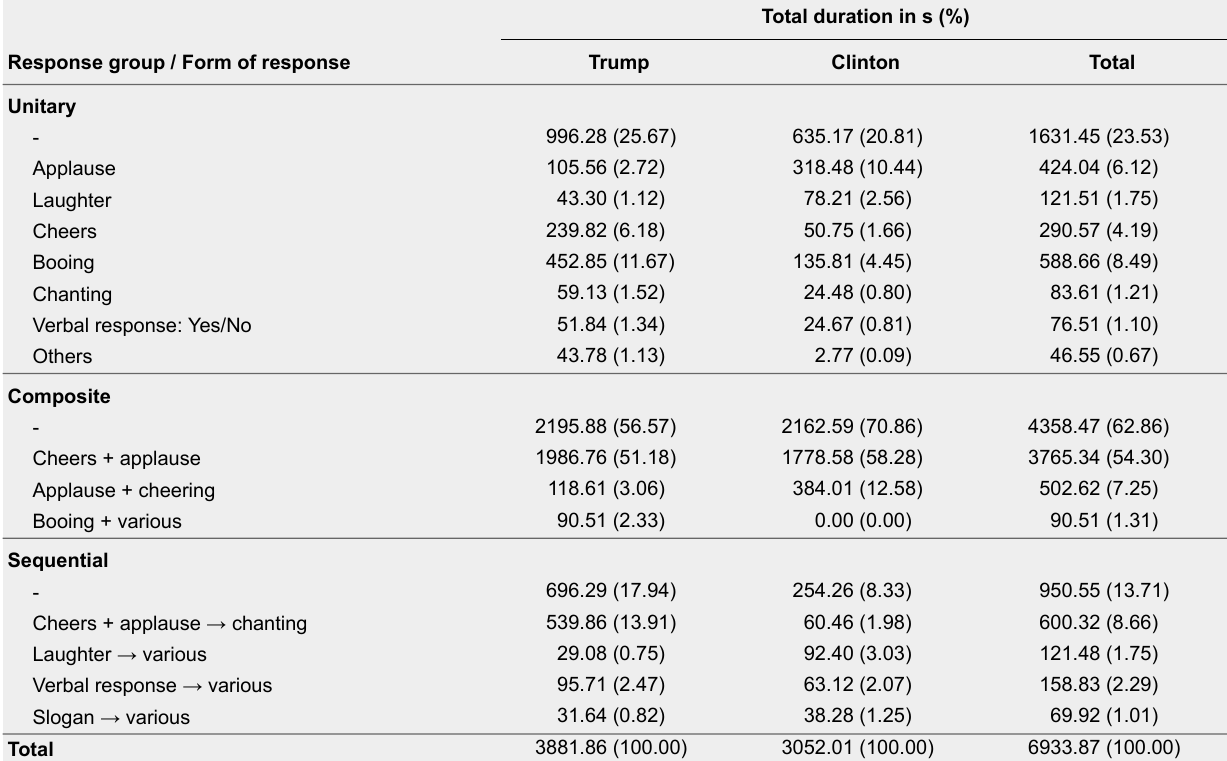
Summary of the Duration Totals for Audience Responses Evoked by Each